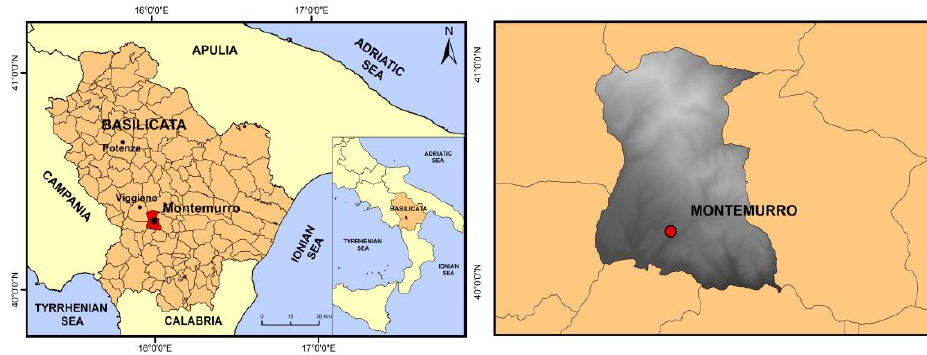
Figure 1. Geographical sketch showing the location of the study area. The sketch also includes the location of Viggiano municipality to which the next sections also refer.